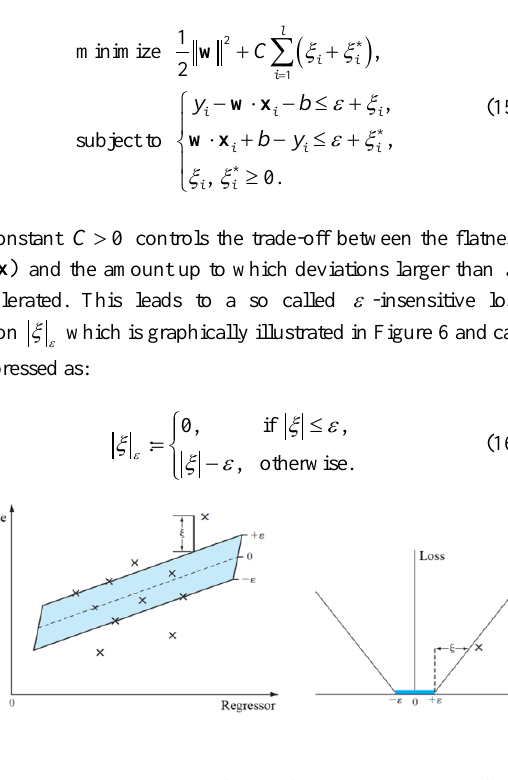
Figure 6: A basic illustration of the soft margin loss setting for a linear SVM (Haykin, 2009).